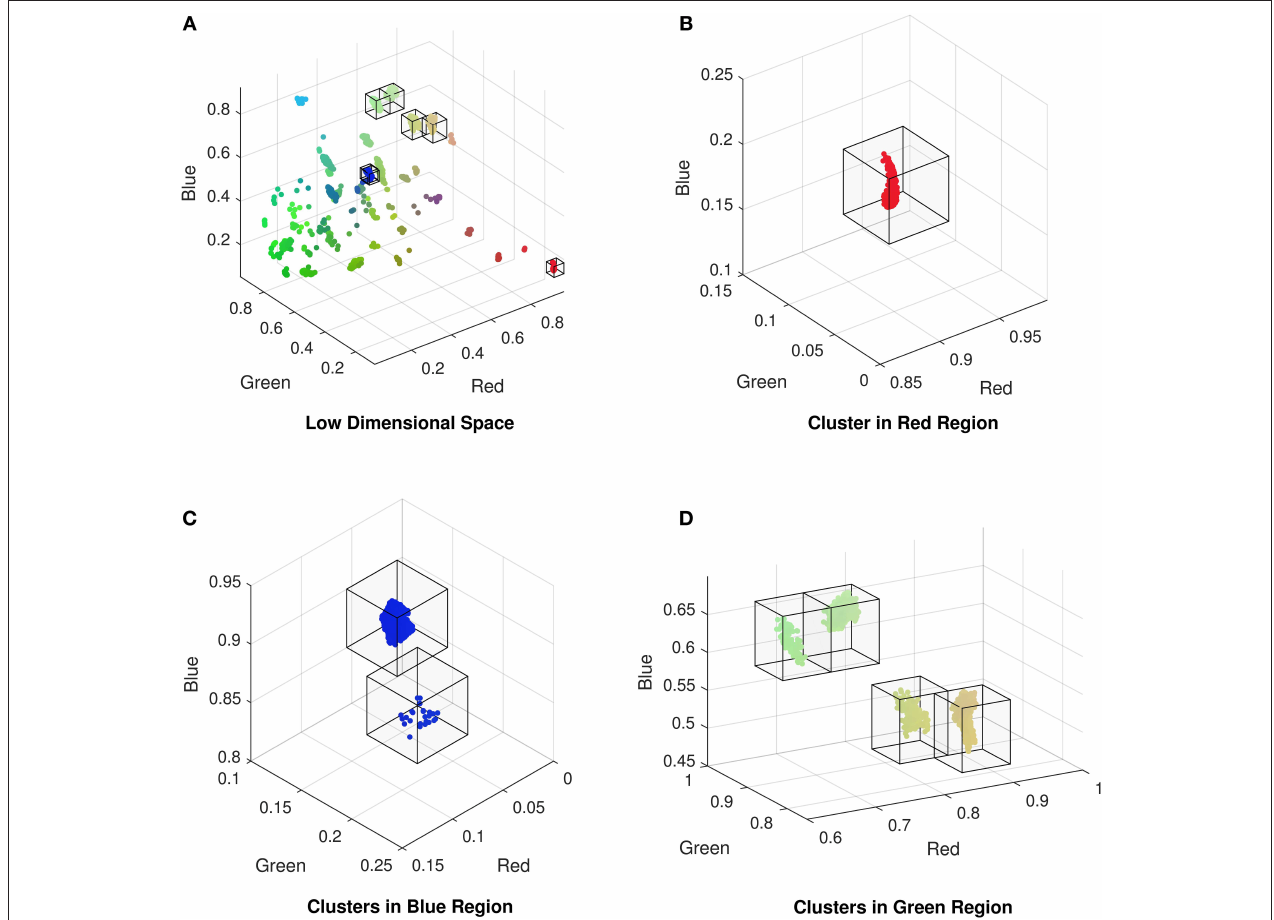
FIGURE 3 | (A) Low dimensional representation of the CMR data following reduction with the autoencoder exhibiting the formation of clusters of CMR data. Isolated clusters in the (B) red, (C) blue, and (D) green regions of the low dimensional (RGB) space (omitting empty regions for